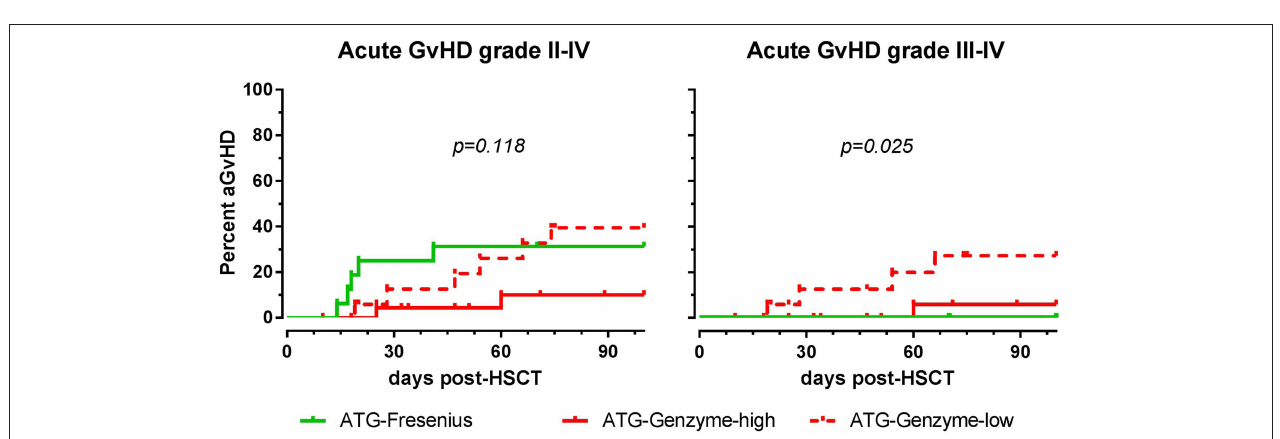
FIGURE 5 | The effect of ATG brand and dosing on acute GvHD. Although not significant, acute GvHD (grade II-IV) occurred less frequently in ATG Genzyme high dose (ATG-GENZ-high) receiving patients compared to patients receiving a low dose of ATG-Genzyme (ATG-GENZ-low) or ATG Fresenius (ATG-FRES). For severe acute GvHD (grade III-IV), there was a significant difference between the three ATG groups. Severe acute GvHD occurred most frequently in the ATG-GENZ-low group.